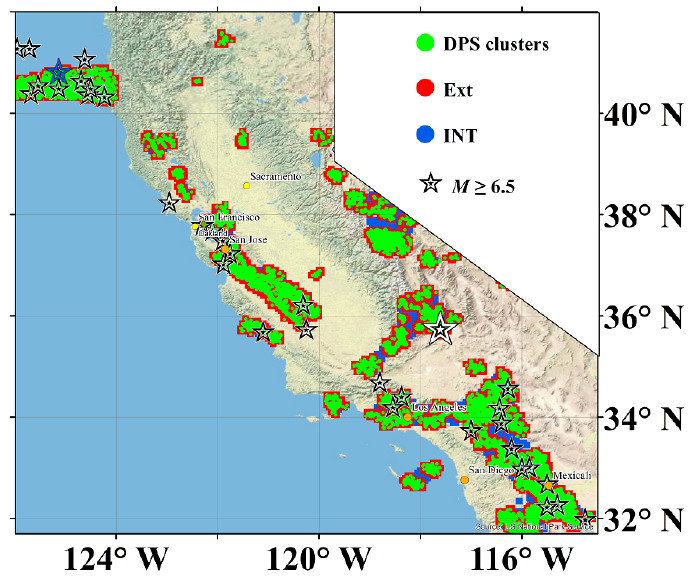
Figure 11. New FCAZ zones prone to earthquakes with M ≥ 6.5 in California and earthquake epicenters with M ≥